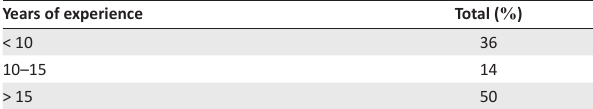
TABLE 5: Work experience of respondents.